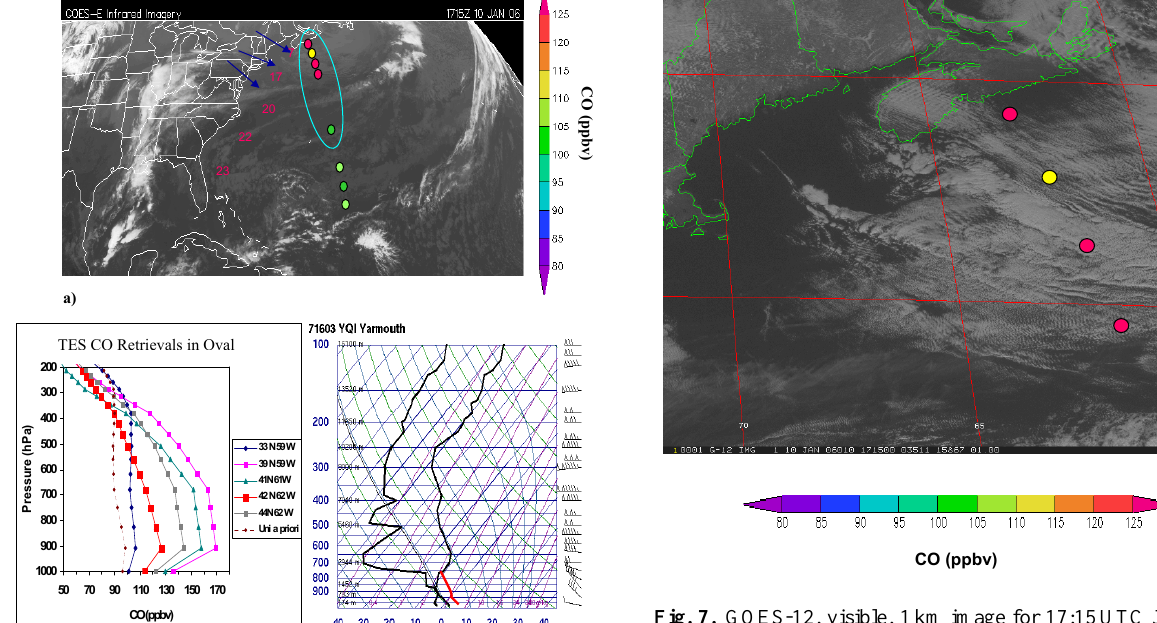
Fig. 7. GOES-12, visible, 1km image for 17:15UTC January 10,